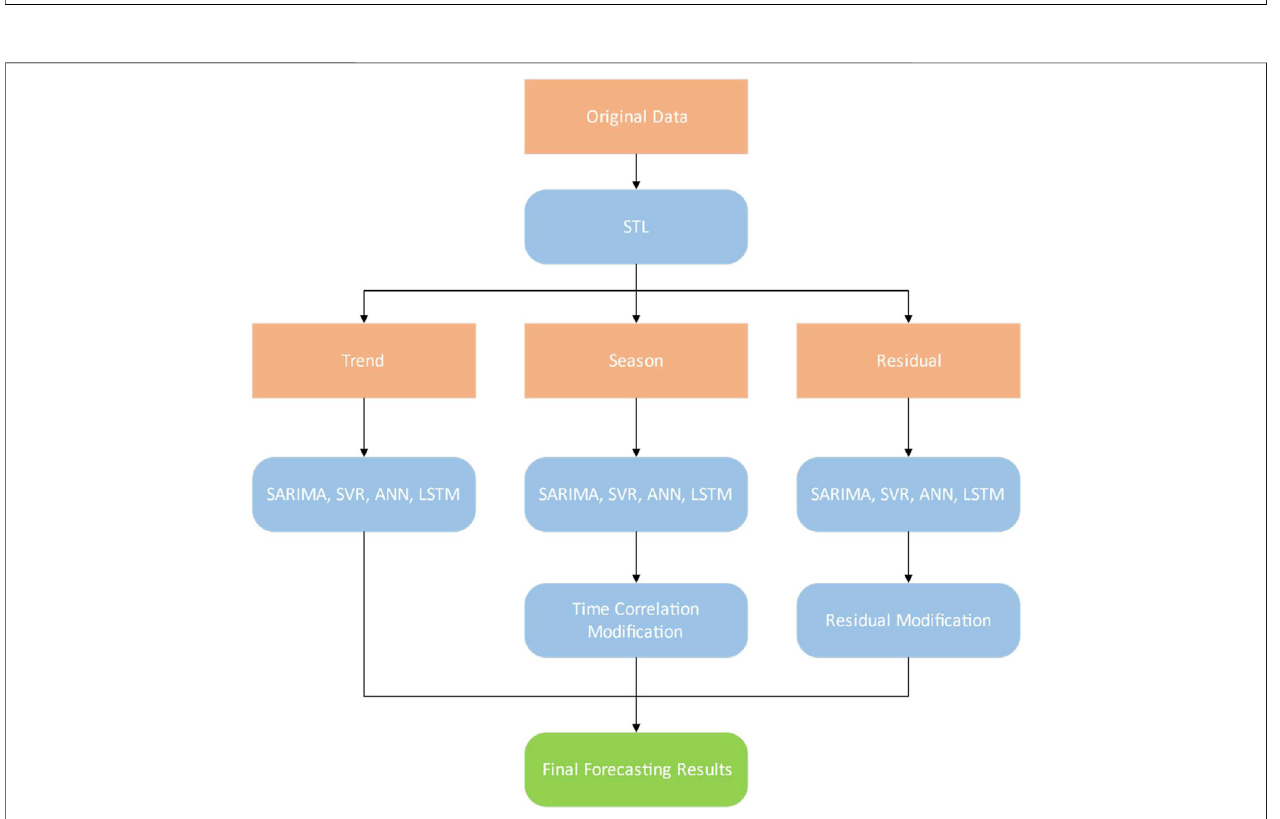
FIGURE 2 | The proposed forecast